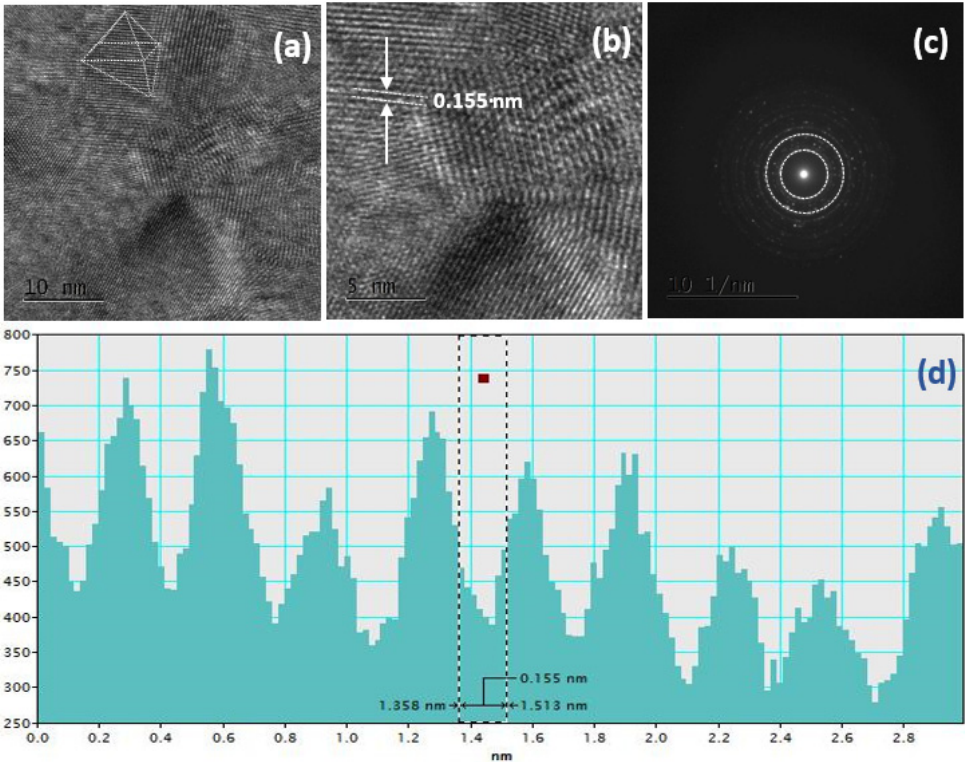
Figure 5. ( a , b ) HR-TEM images, ( c ) SEAD pattern, and ( d ) d-spacing of CeO 2 /NiO nanocomposite. FTIR spectrum of CeO 2 /NiO nanocomposite in the range of 400–4400 cm − 1 is shown in Figure 6. Here we observed multiple peaks corresponding to bond stretching and bond vibrations of metal oxides.